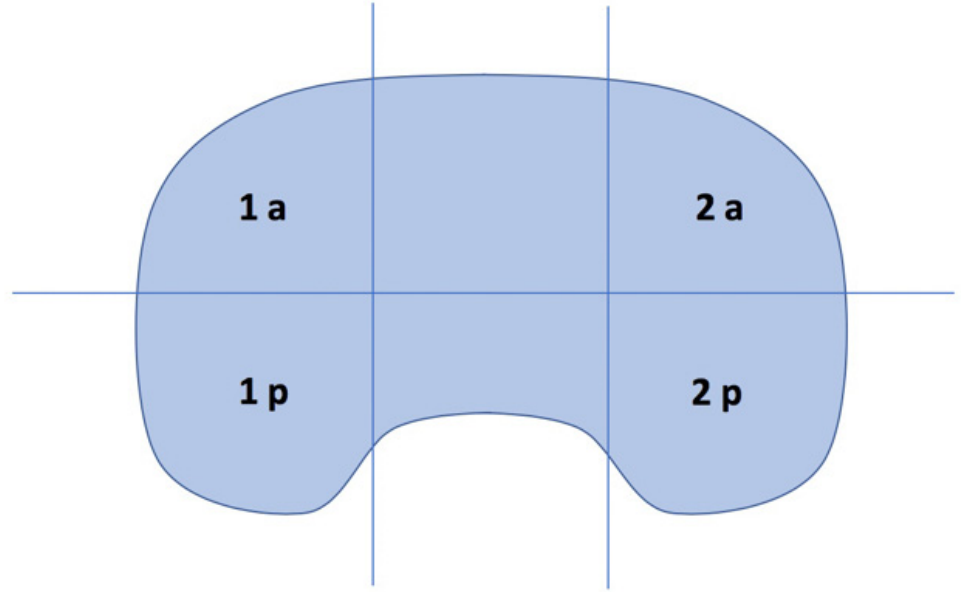
Figure 2. The division scheme of the tibial region for the SPECT/CT localization [10]. In the present study only the medial (1a and 1p) and lateral (2a and 2p) sides were analysed. A qualitative comparison of BTU distribution patterns between medial and lateral